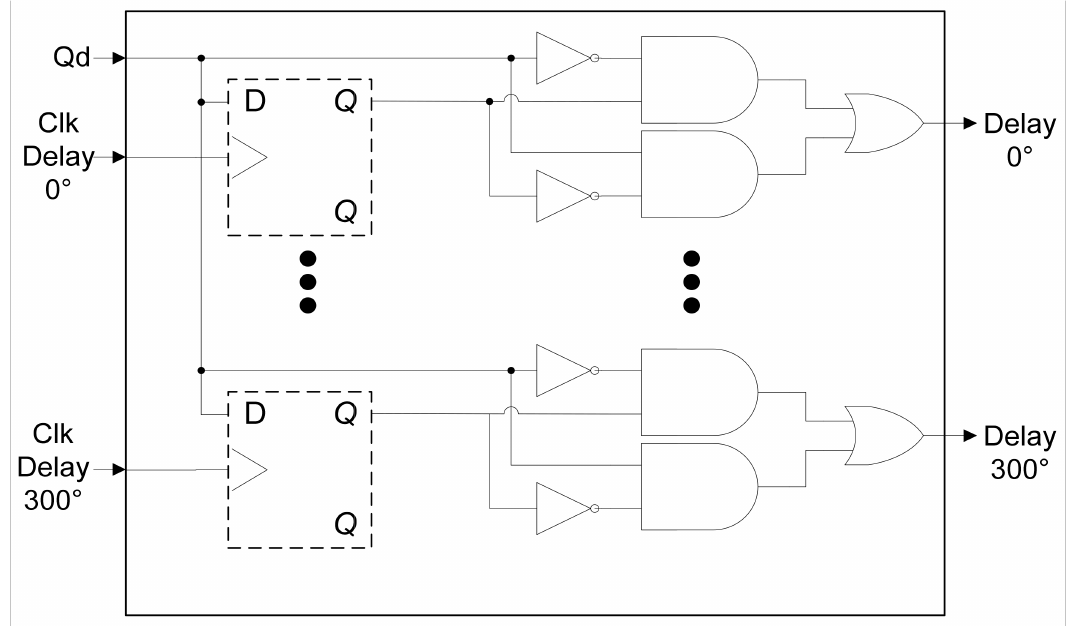
Figure 4. Comparator